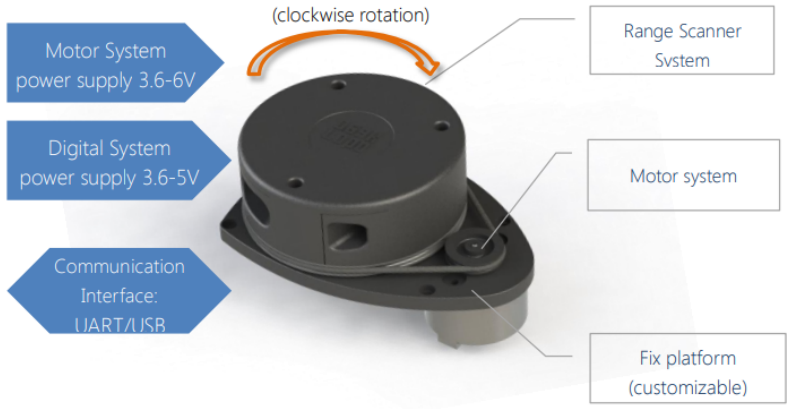
Figure 5. RP-LIDAR System Connection showing the specification of the motor, scanner, and